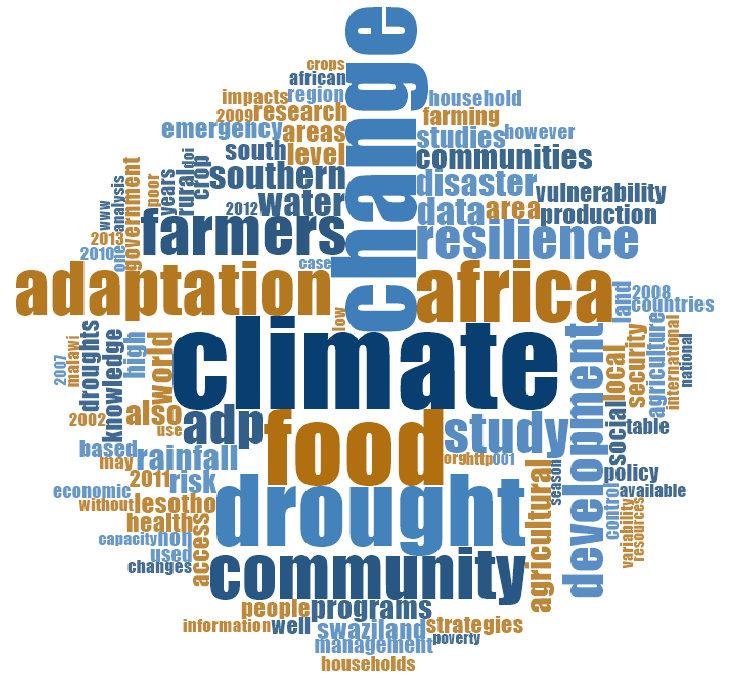
Figure 1. Word cloud. Source : Authors’ own creation.